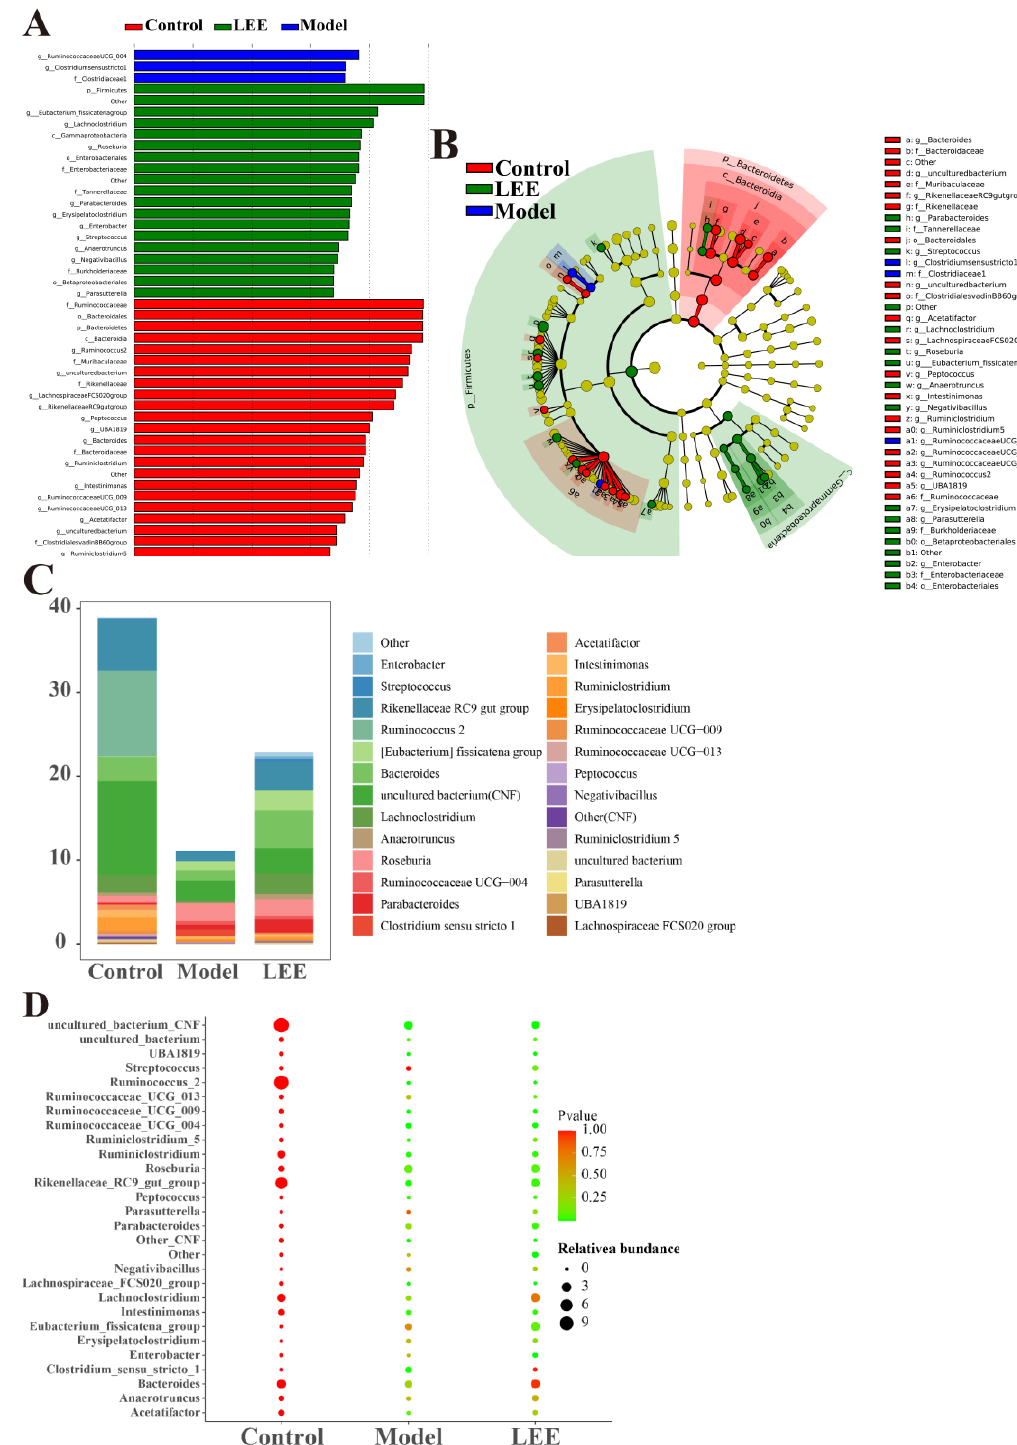
Figure 5. LEfse analyses of intestinal flora in control, model and LEE group. Histogram shows the LDA scores computed for features (genus level) differentially abundant between different groups ( A ). Cladograms representing the LDA effect size ( LEfse ) results for the control, model and LEE groups ( B ). Composition and abundance of the samples of Enterobacteria at discrepant genus ( C ). p -values and relative abundances of the microbiota markers at the genus level in the different groups. The p -values were calculated by comparison with those of the control group ( D ).